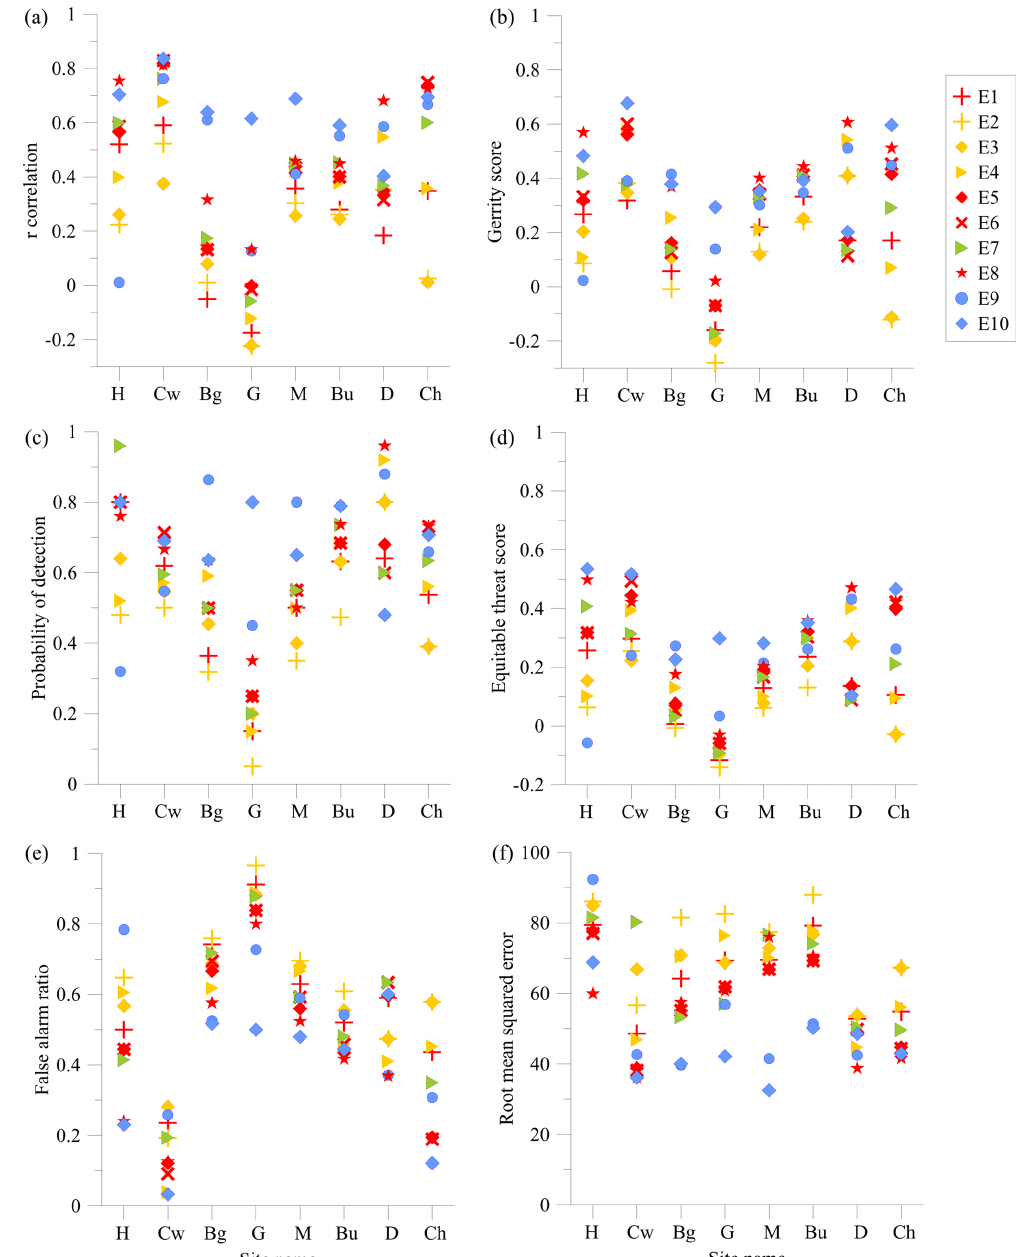
Figure 7. Results from the pollen emission methodology scenarios: (a) Pearson correlation, (b) Gerrity score, (c) POD, (d) ETS, (e) FAR and (f) RMSE. The sites are presented from west to east, and red refers to Gaussian methodologies, yellow refers to ∂ EVI methodologies, green refers to the production–loss model and blue refers to statistical methodologies. A higher score is better for the Pearson correlation, Gerrity score, POD and ETS. A lower score is better for the FAR and